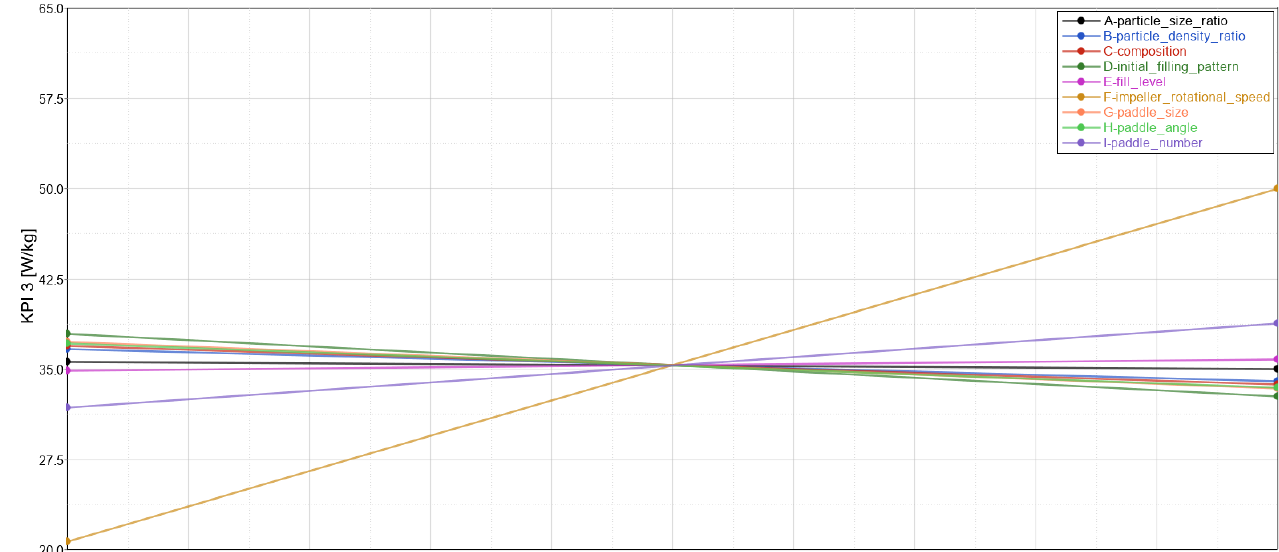
Figure 11. The main effect of factors on KPI 3 average mixing